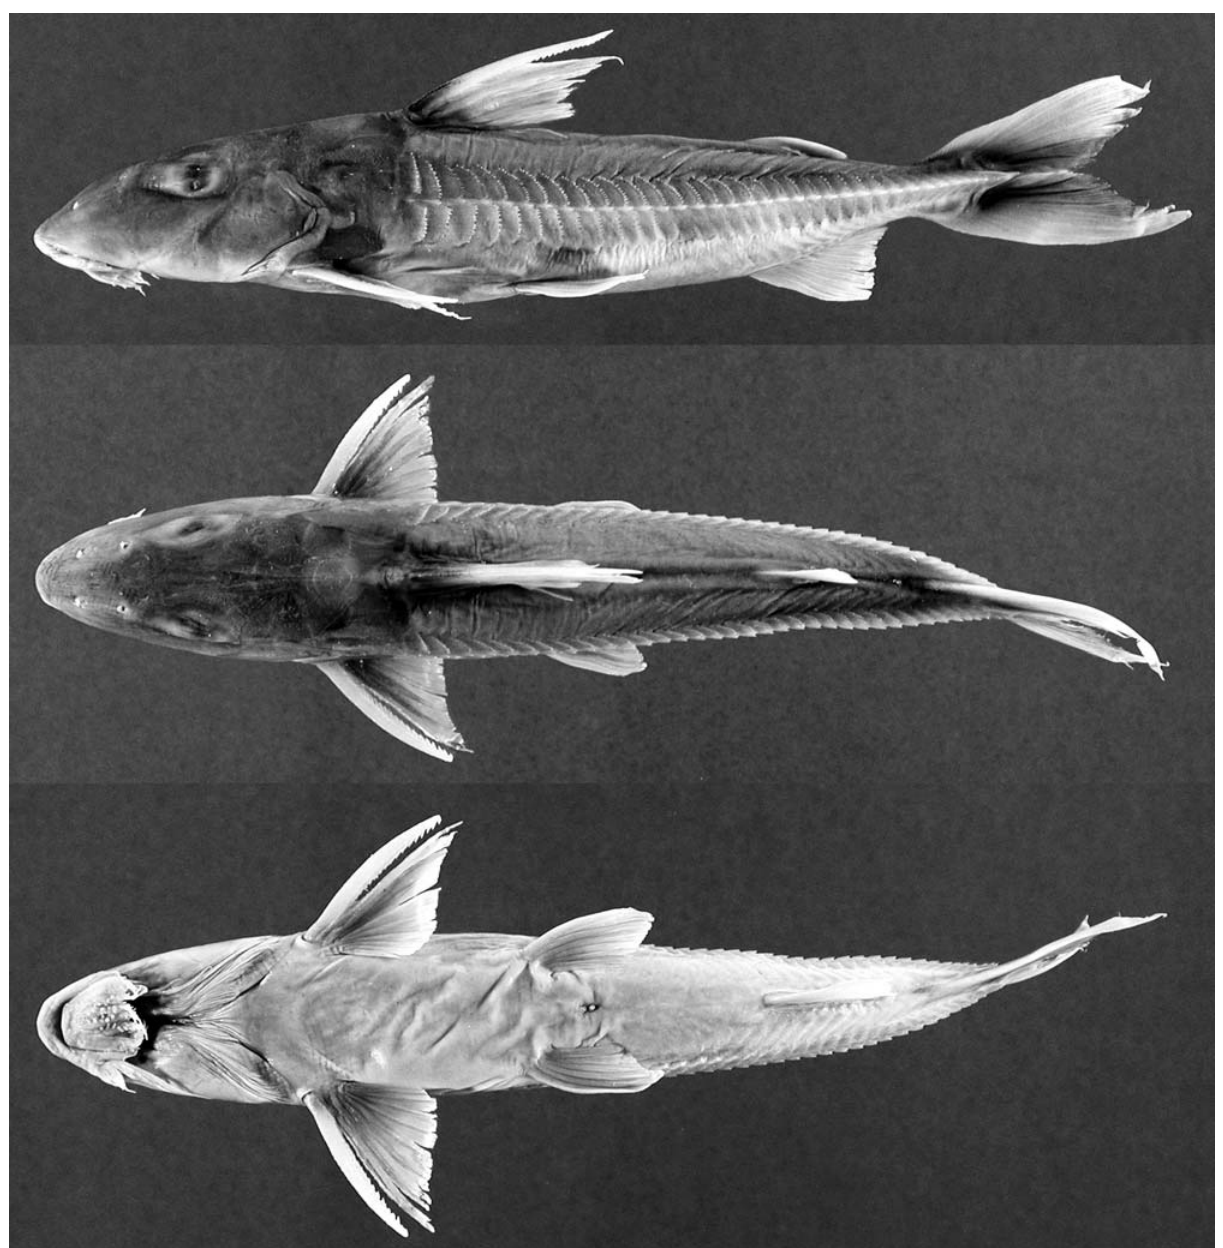
Fig. 10. Leptodoras copei , ANSP 162466 (SL 141.5 mm), río Orinoco (Atlantic dr.), near mouth of río Iguapo, Amazonas,